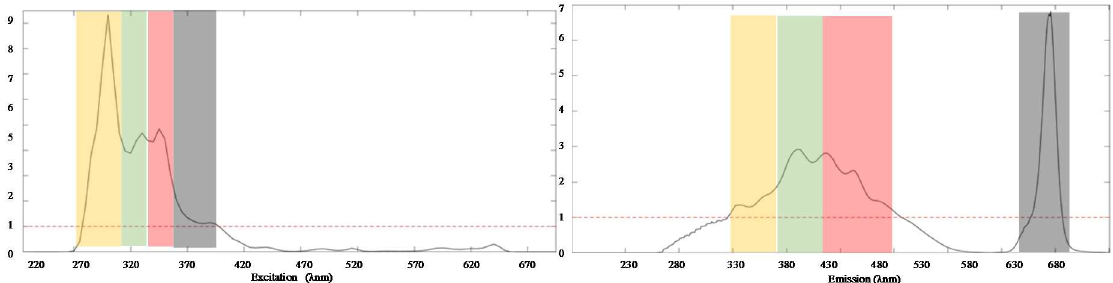
Figure 5. Variable importance plot (VIP) loading of DN-PLSR highlighting the four main regions of importance, as previously identified through PARAFAC, which correspond to the phenolic compounds (yellow), tocopherols (green), oxidised products (red) and chlorophylls (black).